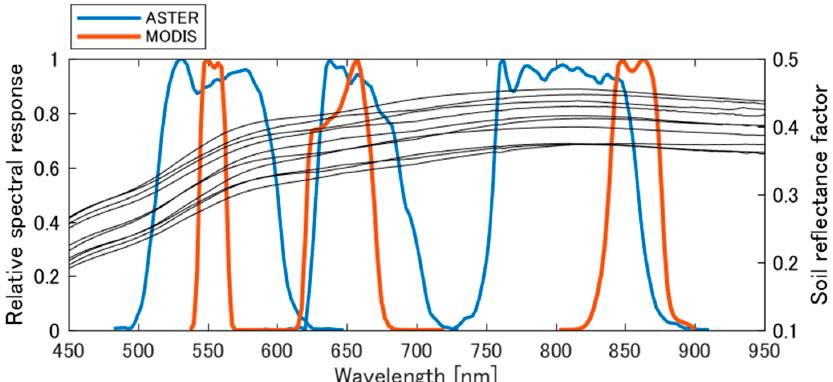
Figure 1. Relative spectral response (RSR) of ASTER bands 1, 2, and 3N and MODIS bands 4, 1, and 2, respectively. Ten samples of soil reflectance factors of the Railroad Valley Playa used in the numerical experiments are plotted.